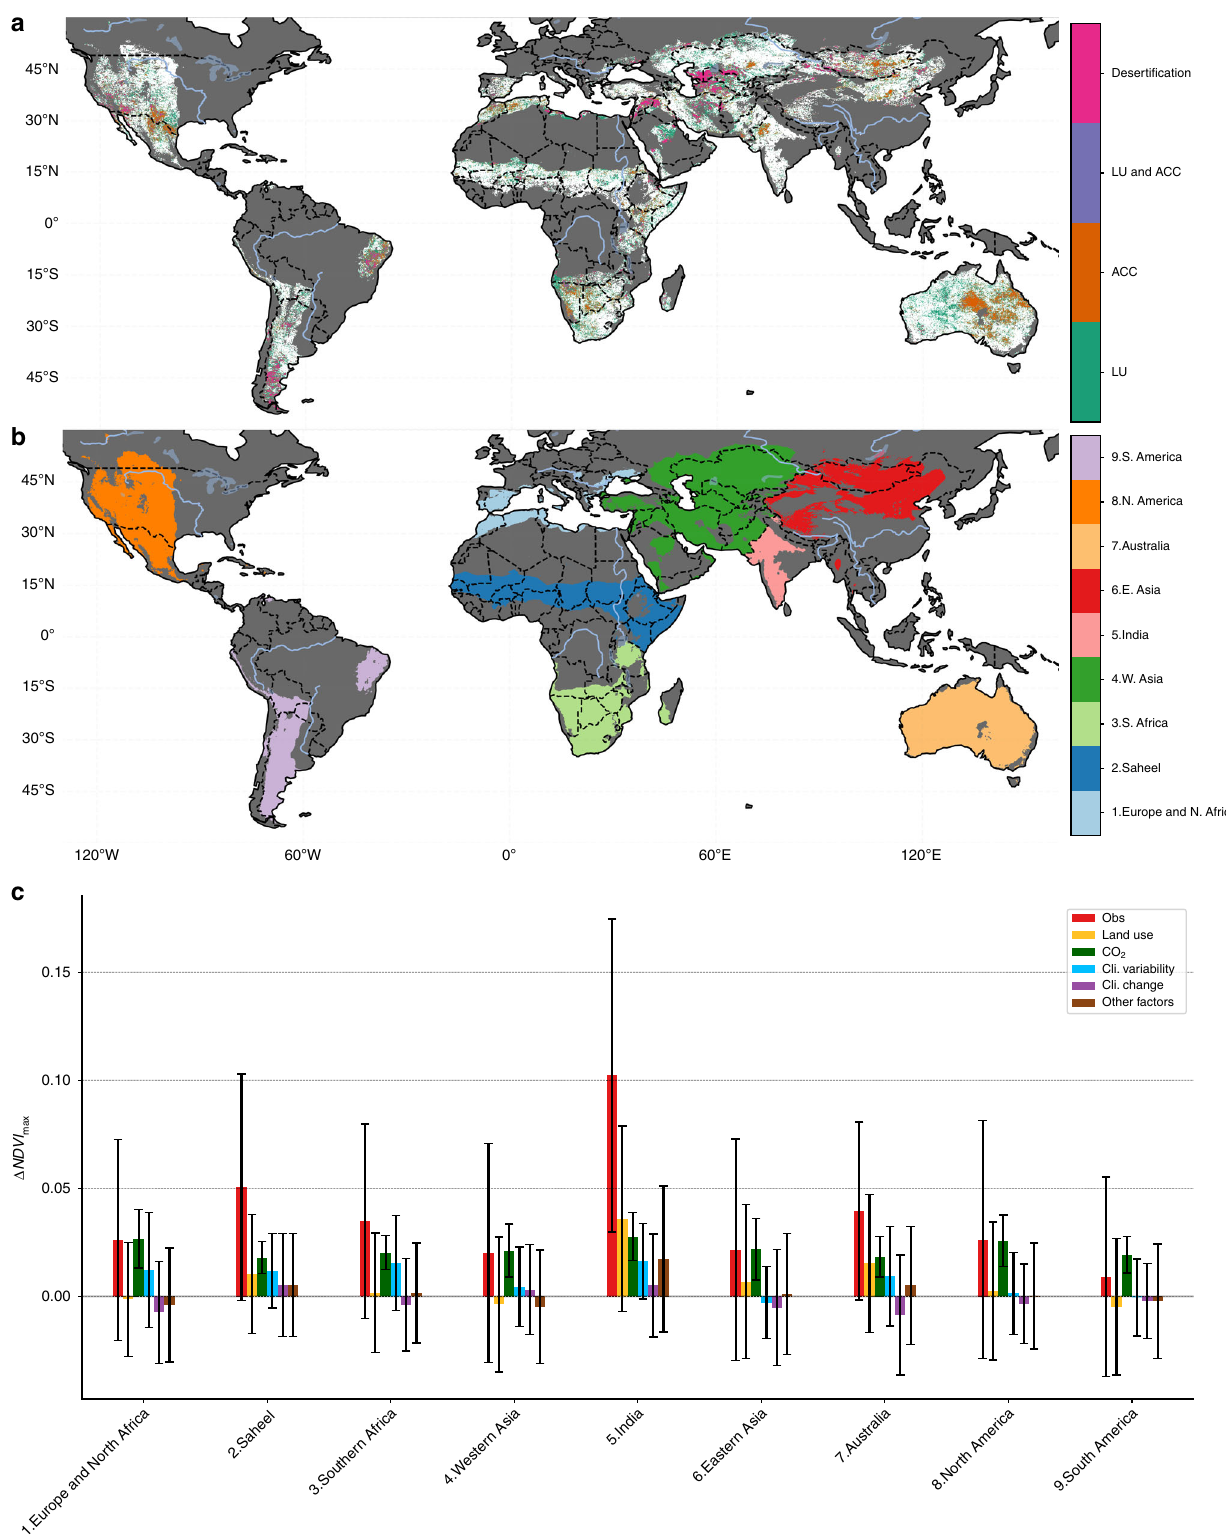
Fig. 3 Deserti fi cation risk and regional drivers. a Regions experiencing, or at risk of experiencing, deserti fi cation. Areas with a signi fi cant negative change in vegetation ( α FDR = 0.10) are classi fi ed “ Deserti fi cation, ” areas where the anthropogenic climate change (ACC: CO 2 + Climate Change) and land-use (LU) components are both negative but the change in vegetation is not signi fi cant are classi fi ed as “ LU and ACC. ” Areas where the anthropogenic climate change has had a negative effect are classi fi ed as “ ACC ” and areas where land use had a negative impact classi fi ed as “ LU. ” b map of the regional subdivisions used. c The mean per-pixel Δ NDVI max and its drivers broken down by regions shown in b . The error bars show the